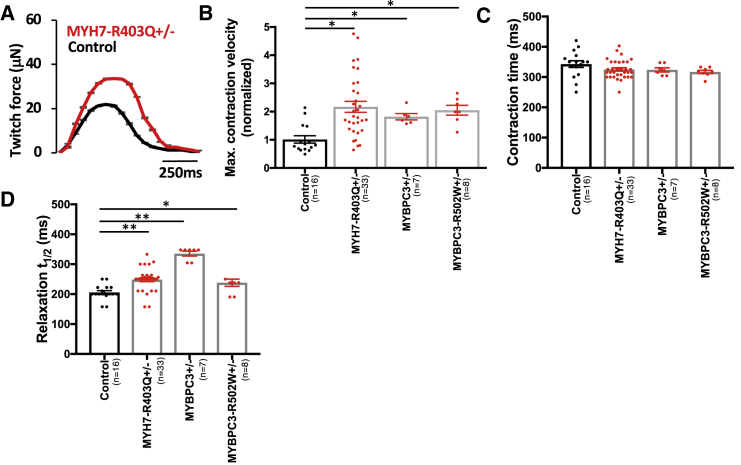
Contraction and Relaxation Kinetics Are Altered by HCM Mutations(A) Representative twitch force tracings from MYH7-R403Q+/– CMT models compared with isogenic controls.(B–D) Normalized maximum contraction velocity (B), contraction time (C), and relaxation half-time (t1/2) (D) for MYBPC3+/−, MYBPC3-R502W+/–, and MYH7-R403Q+/– compared with controls.Significance was assessed by ANOVA (B–D) (∗all p < 0.05 and ∗∗all p < 0.001); data are means ± SEM (error bars) (A–D). Each data point represents a single CMT (B–D) generated by at least three biological replicates by iPSC differentiation batch.